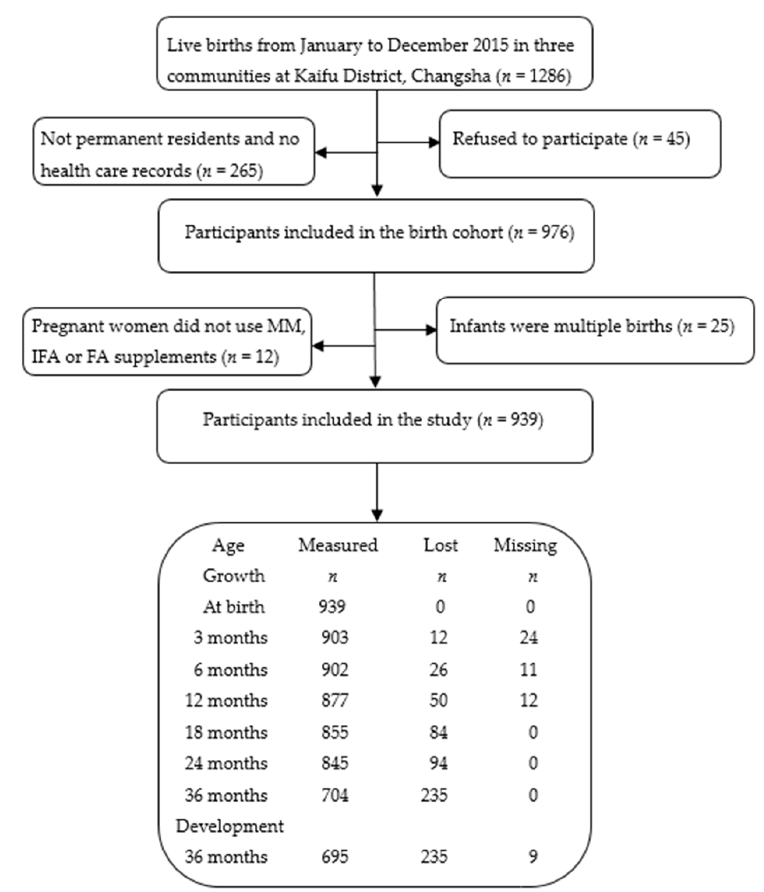
Figure 1. Participant flow diagram for effects of maternal prenatal multi-micronutrient supplementation on growth and development until 3 years of age. (Abbreviation: MM, multi-micronutrient; IFA, iron–folic acid; FA, folic acid).